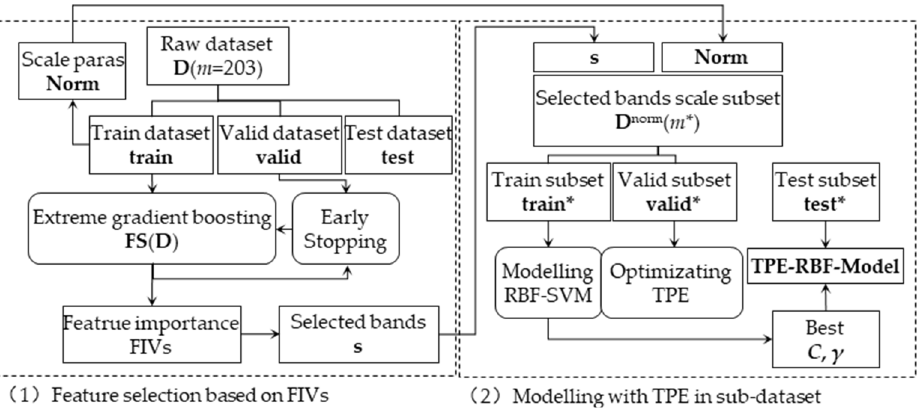
Figure 3. Flow chart of feature selection and optimized RBF-SVM modelling.